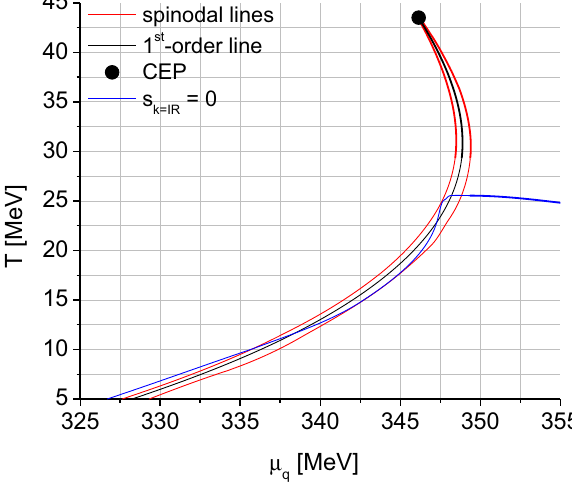
Fig. 2 First order phase transition of the QM model without vector interactions. The red lines are the spinodals, the black line is the first order phase transition line and the CEP is the black dot. The blue line corresponds to the s k = IR = 0 line and below this line entropy density is